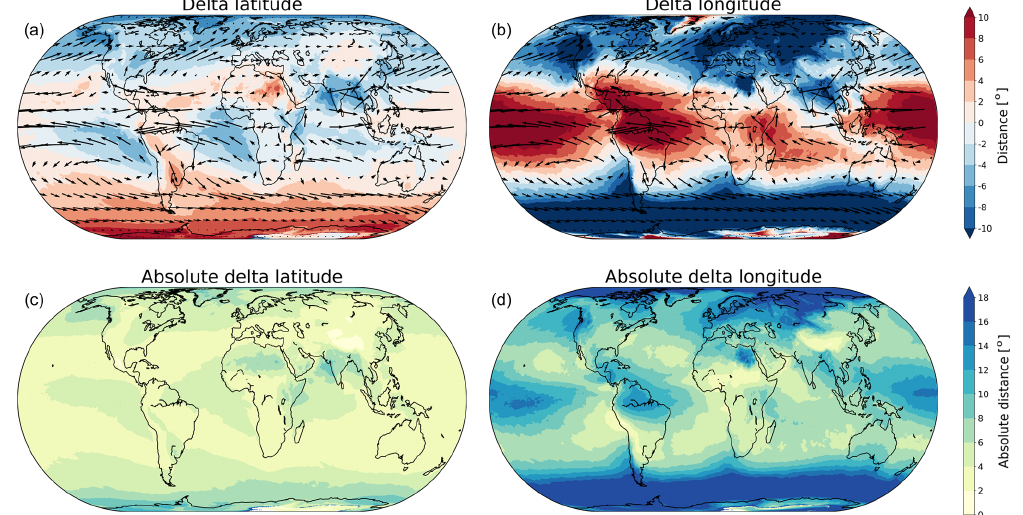
Figure 7. Average backward moisture transport from precipitation to evaporation. (a) Average of traveled distance in meridional direc- tion (“delta latitude”). (b) Average of traveled distance in zonal direction (“delta longitude”). (c) Average of absolute traveled distance in meridional direction (“absolute delta latitude”). (d) Average of absolute traveled distance in zonal direction (“absolute delta longitude”).